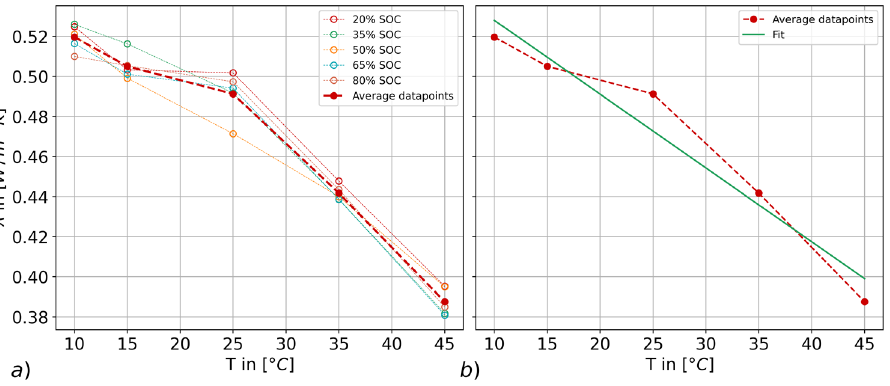
Figure 13. Development of cross ‐ plane thermal conductivity λ ⊥ over temperature for all covered SOC. ( a ) Measurement points and the average at every data point. ( b ) Average at every data point and corresponding linear fit.